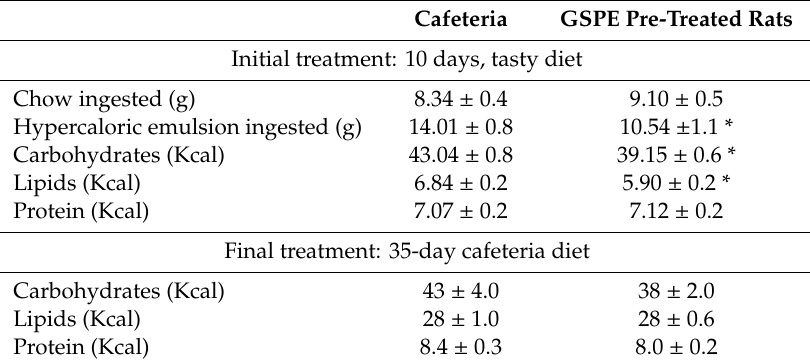
Table 1. Characteristics of food intake during the short cafeteria